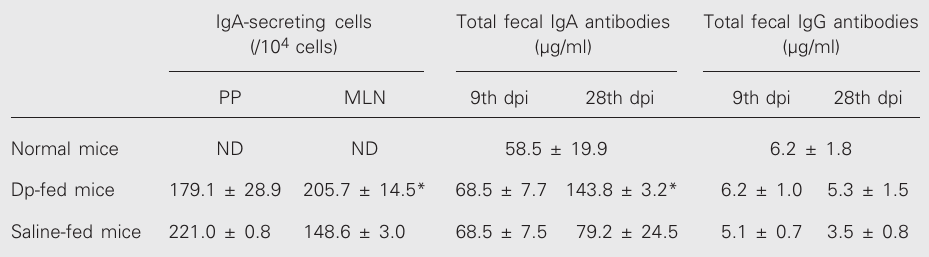
Table 1. Number of IgA-secreting cells in the gut-associated lymphoid tissue and fecal immunoglobulin levels of sensitized Dermatophagoides pteronyssinus (Dp)-fed mice. IgA-secreting